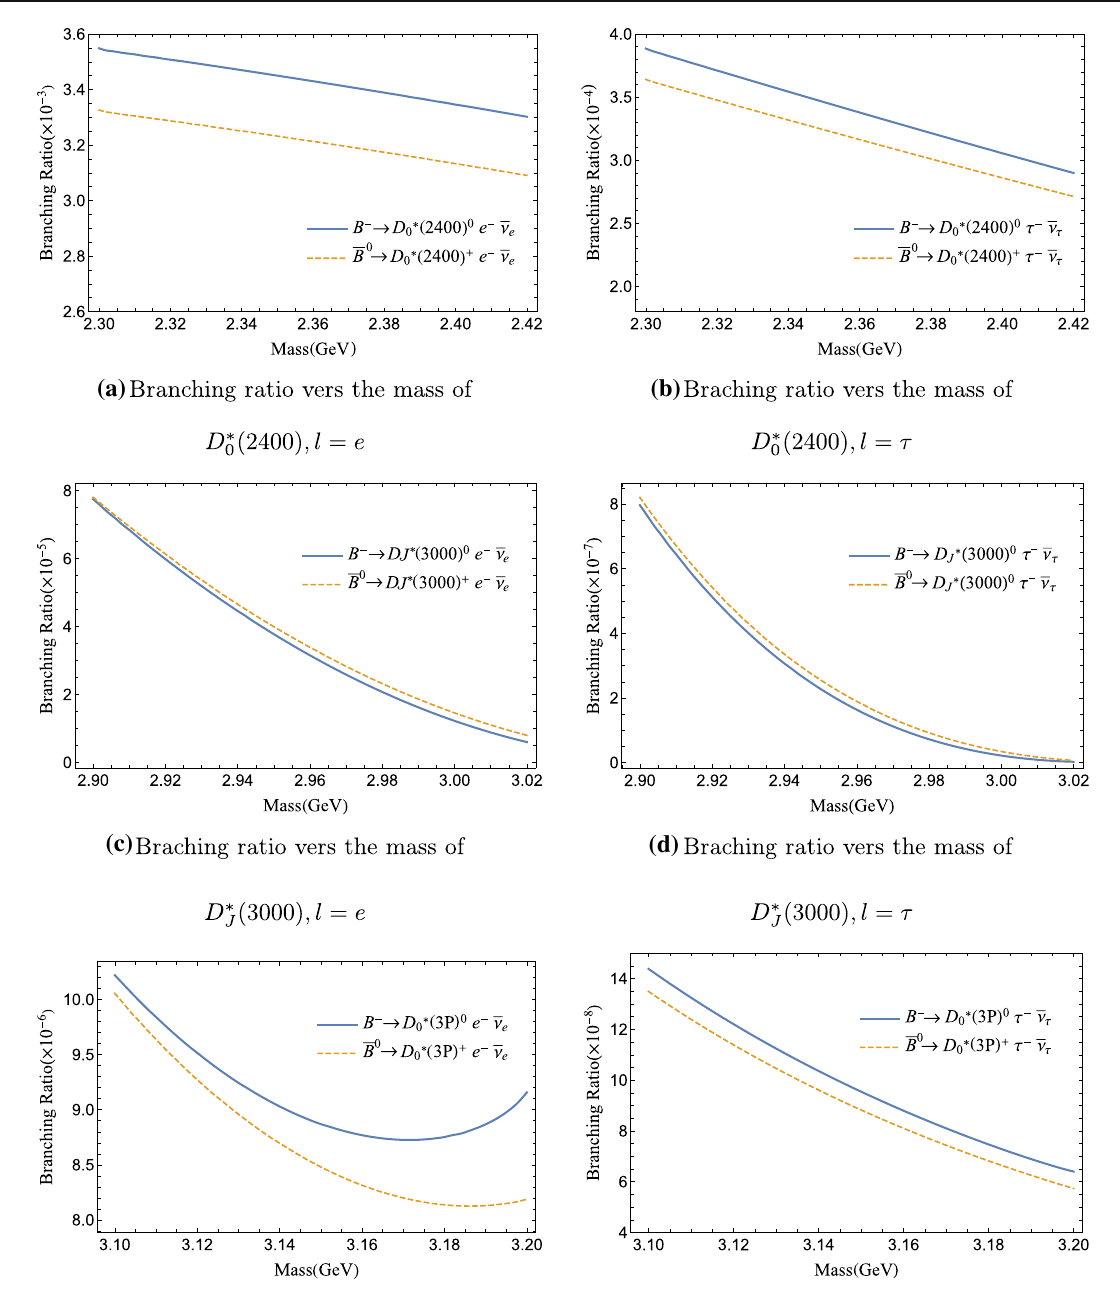
Fig. 5 The branching ratios of semi-leptonic production change with the mass of D ∗